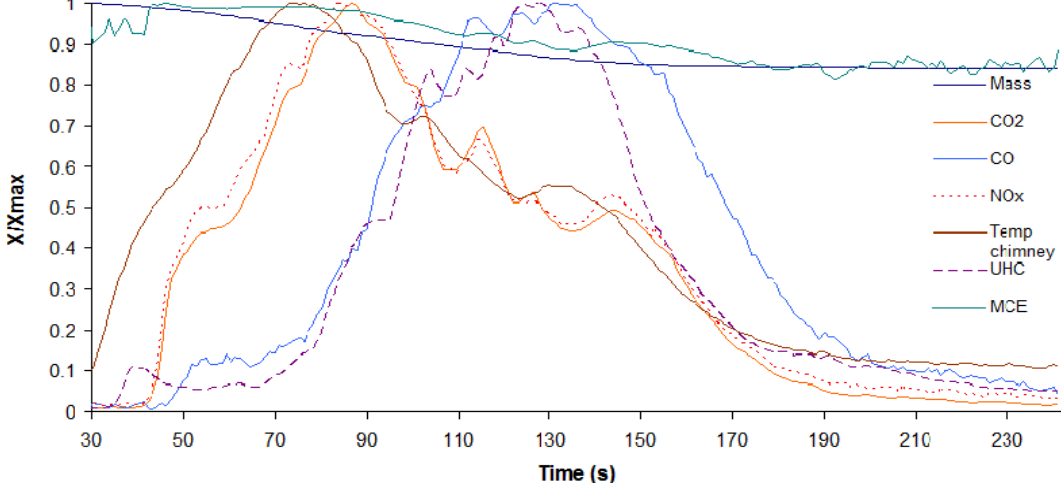
Figure 2. Example of the typical pattern of the combustion process observed in one of the experiments conducted in the laboratory. Normalized data, as a function of time: gas emissions and their relation with the combustion phases.